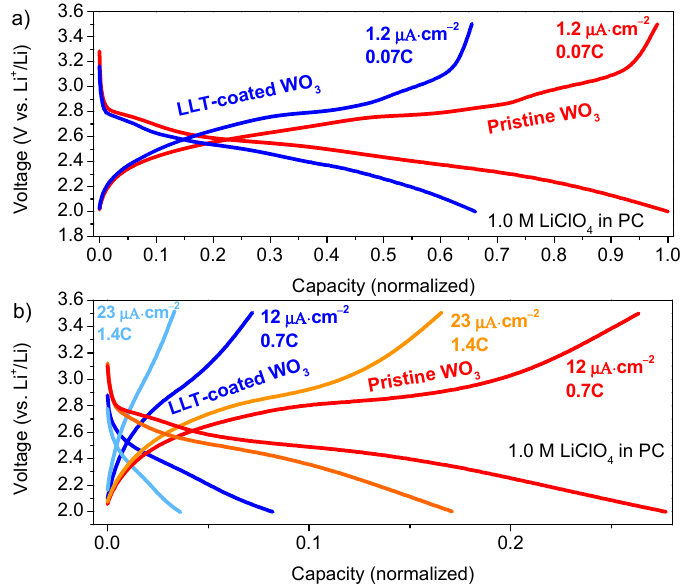
Figure 5. Lithiation/delithiation curves of 10 cycles W-precursor deposition on a planar Pt substrate, annealed at 600 °C for 1 h in static air and LLT-coated WO 3 (prepared under the same conditions) annealed at 500 °C for 1 h in static air. The figure shows samples measured at: ( a ) low; and ( b ) high current densities. The capacity is normalized according to pristine WO 3 cycled at 1.2 μ A·cm − 2 (0.07C). In all cases, the 10th cycle at the specified C-rate is shown.